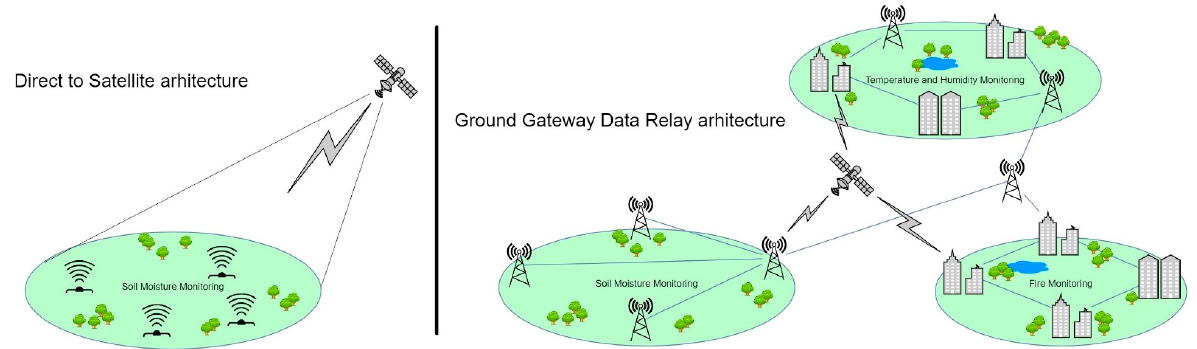
Figure 1. Direct-to-Satellite (DtS) vs ground data relay architecture.